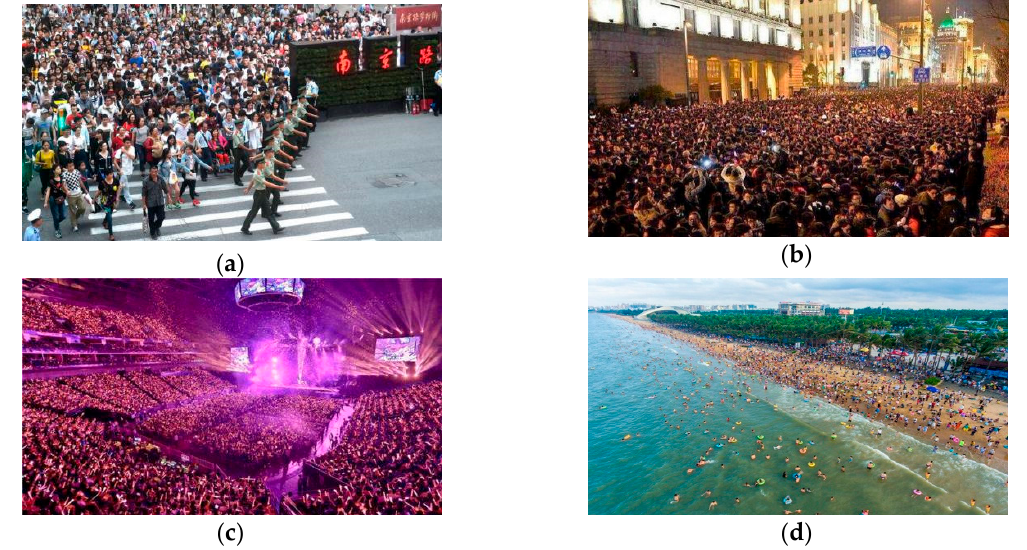
Figure 1. ( a ) Pedestrian Street. ( b ) Festival celebration. ( c ) Sports event. ( d ) Tourist